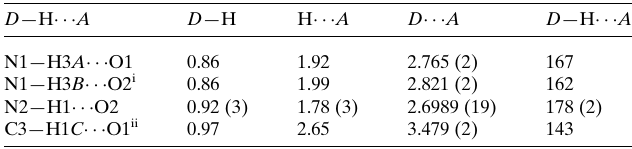
Table 1 Hydrogen-bond geometry (A˚ , (cid:4) ) for